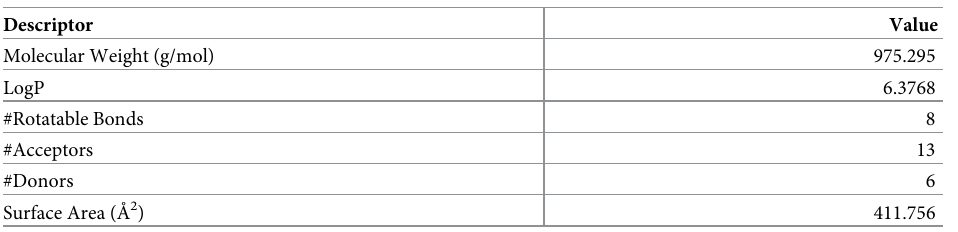
Table 2. Chemical structural properties of